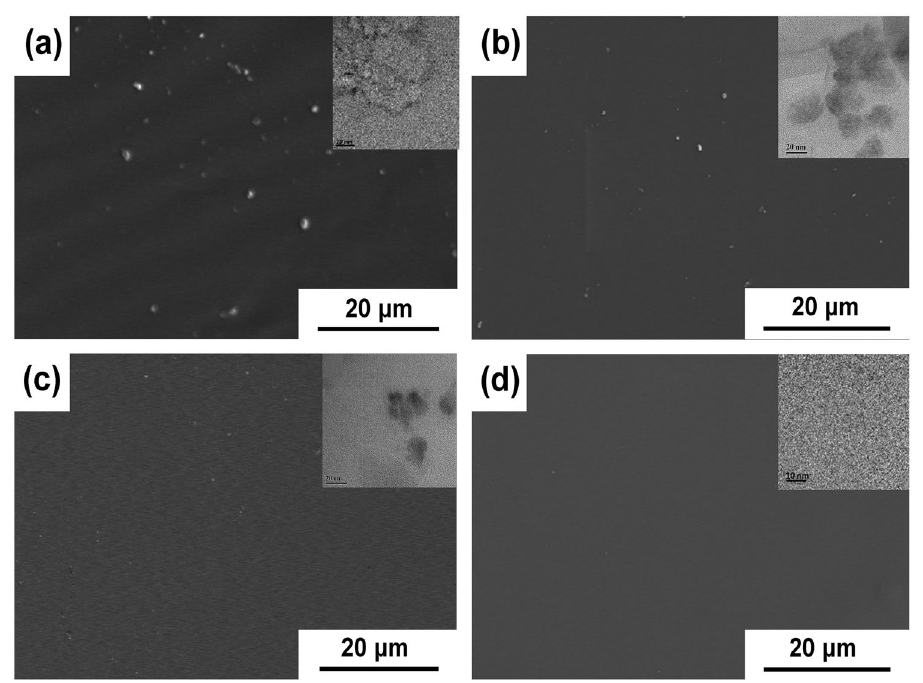
Figure 3. SEM images of the cross sections of silicone nanocomposites with 1 wt% ( a ) TiO 2 -3, ( b ) TiO 2 -2, ( c )